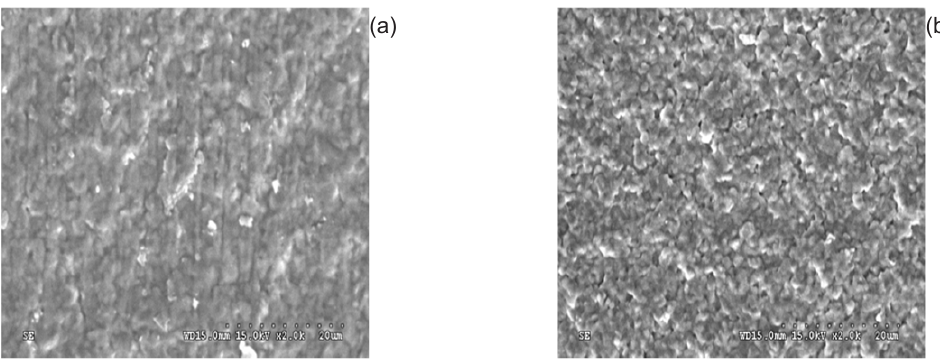
Figure 2. SEM micrographs of the surface of Ti–6Al–4V alloy with nitride coating based on Ti